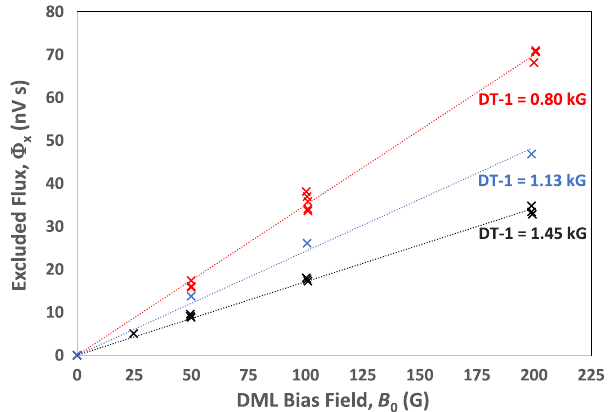
FIG. 12. Tuning curve for DT-1 focusing solenoid showing the beam rms radius predicted by XTR at the DML location for a normalized 4-rms emittance of 0.071 cm rad (blue curve). DML measurements of rms radius averaged over flattop are plotted in